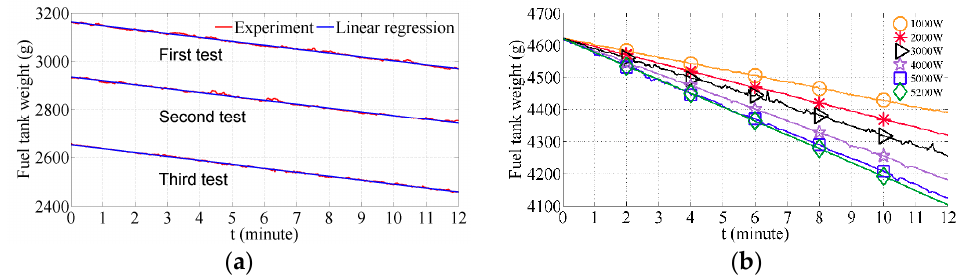
Figure 12. ( a ) Declining curve of fuel tank weight in load-free test; ( b ) Declining curve of fuel tank weight at different output power.